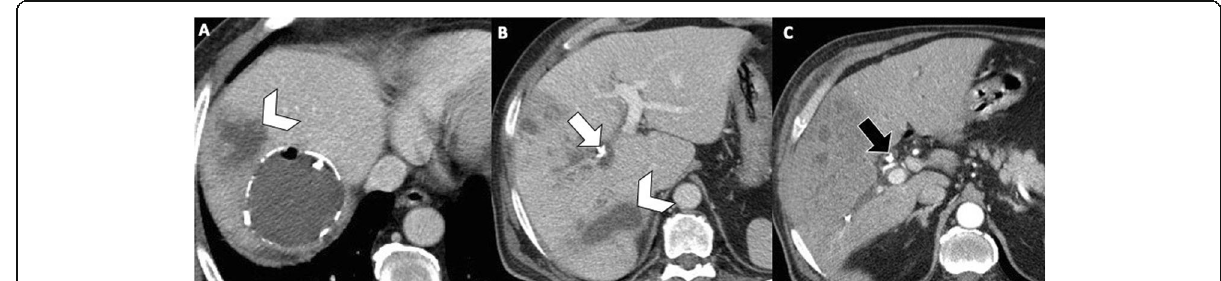
Fig. 14 A 57-year-old man with communicating rupture and superinfection of liver hydatid cyst. Axial contrast-enhanced CT images at different levels ( a , b ) show multiple intrahepatic abscesses (arrowheads), adjacent to a hydatid cystic lesion with peripheral wall calcifications and intracystic air content. Note a calcified fragment of wall cyst within the right intrahepatic bile duct (white arrow), which migrates into the common bile duct (black arrow) at 10-days CT follow-up ( c )